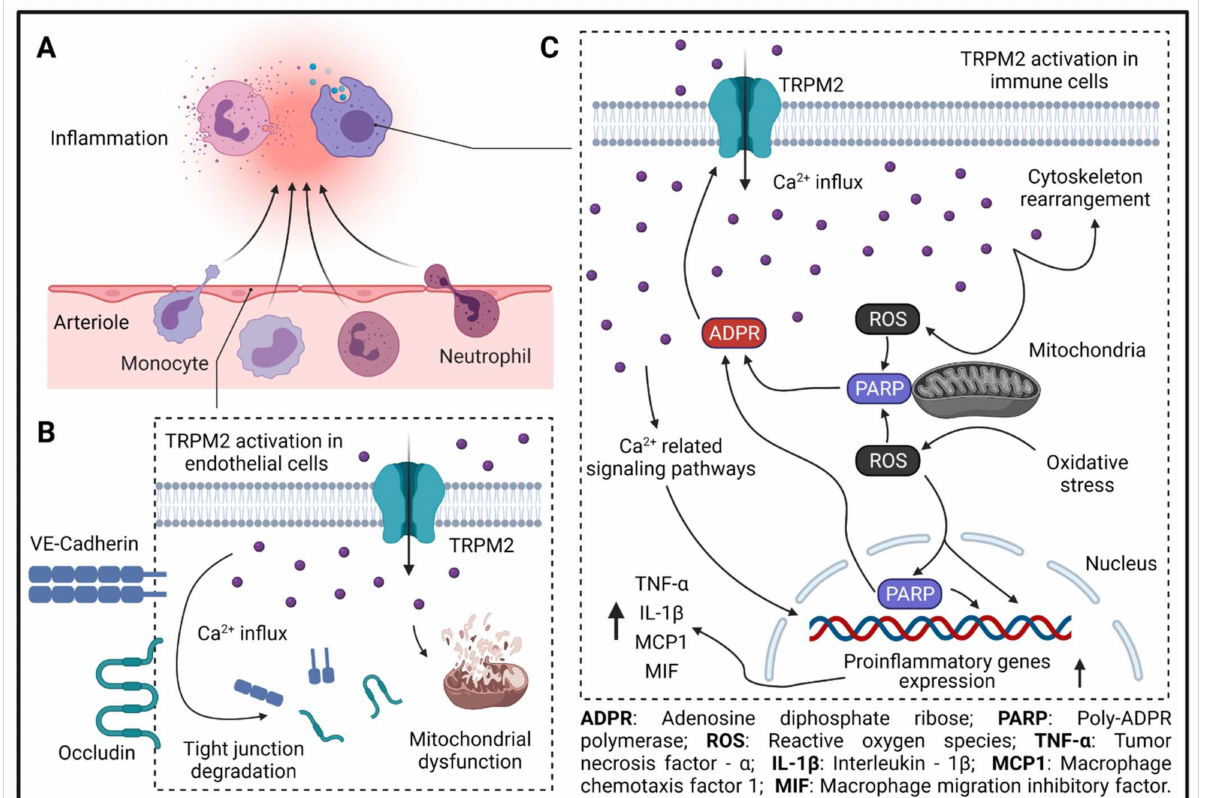
Figure 3. TRPM2 in inflammation. ( A ) Leukocyte extravasation during inflammation. ( B ) TRPM2- mediated Ca 2+ influx leads to tight-junction molecule degradation (VE-cadherin and occludin) and mitochondrial dysfunction in endothelial cells. ( C ) TRPM2-mediated Ca 2+ influx is needed for immune cell migration and activation. During inflammation, ROS production in mitochondria is increased, which activates PARP in mitochondria or in the nucleus and enhances the production of ADPR. Increased ADPR potentiates TRPM2-mediated Ca 2+ influx, which further increases the production of ROS in mitochondria, leading to the formation of a feed-forward vicious cycle. ROS-, PARP-, and Ca 2+ -related signaling pathways increase the expression of proinflammatory genes, such as TNF- α , IL-1 β , MCP1, and MIF. Moreover, TRPM2-mediated Ca 2+ influx promotes cytoskeleton rearrangement and immune cell